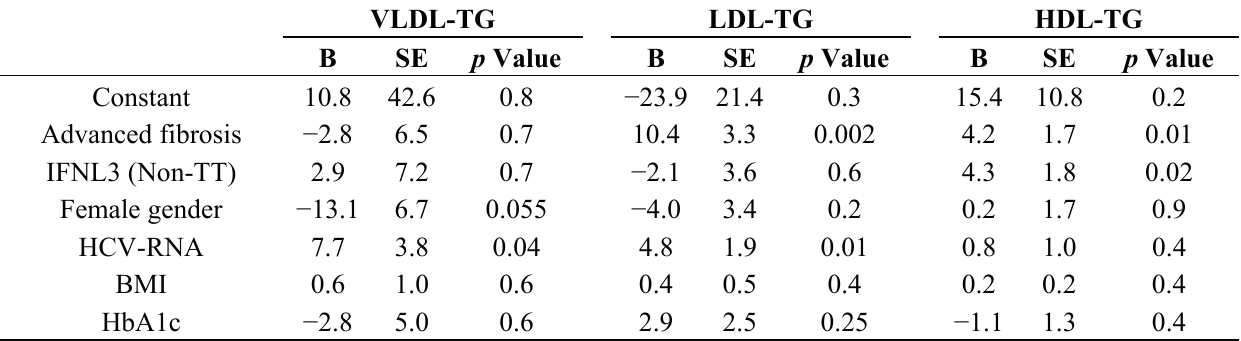
Figure 5. Comparison of the distribution of TG in the four major classes of serum lipoproteins between patients with advanced fibrosis and those with mild-moderate fibrosis (Adv, advanced; Mod, Moderate; * p < 0.05). Table 5. Significance of advanced liver fibrosis in the concentrations of VLDL-TG, LDL-TG, and HDL-TG, as analyzed using multiple regression models. VLDL-TG LDL-TG